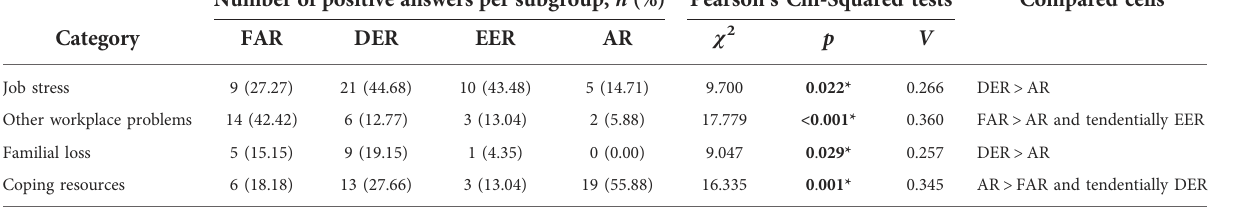
TABLE 5 Numbers of positive answers of inductive categories per AEM-subgroup and results of Pearson ’ s Chi-Squared tests to compare the subgroups within these categories . Number of positive answers per subgroup; n (%) Pearson ’ s Chi-Squared tests